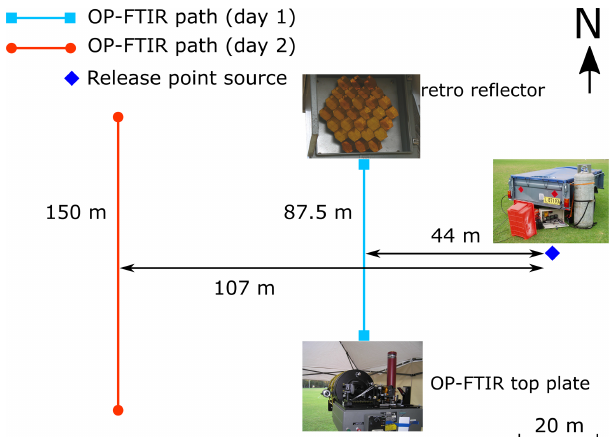
Figure 3. Point gas release sources and OP-FTIR path geometries (distances in m) at Wollongong in August 2005. The OP-FTIR mea- surement path lengths at days 1 and 2 were 87.5 and 150m (two- way path), respectively. Three 1 / 4 (cid:48)(cid:48) (0.635cm) tubes coming from three tanks (CH 4 , natural gas; NH 3 and N 2 O) bundled together on a stake at the release height of 1.28m above ground